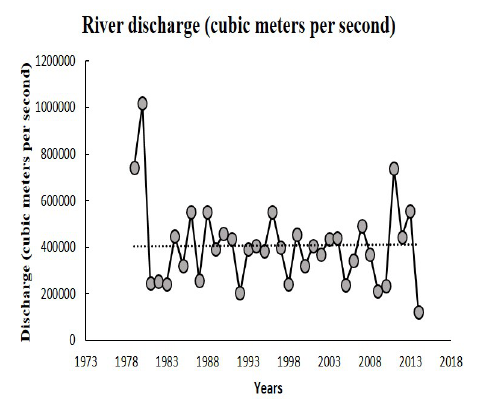
Figure 5. River discharge trend over 35